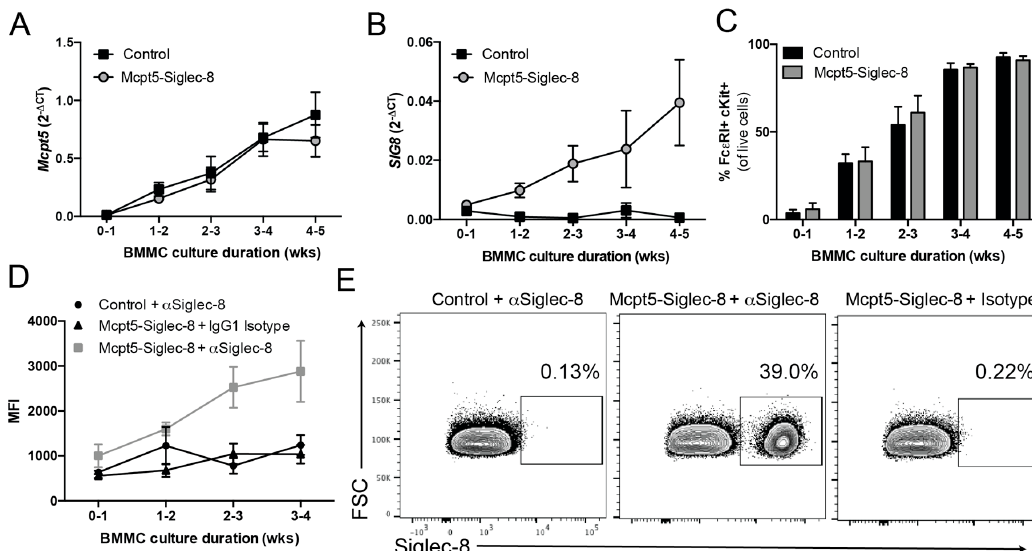
Figure 7. A subset of BMMCs from Mcpt5-Siglec-8 mice express high levels of surface Siglec-8. BMMCs were generated from Mcpt5-Siglec-8 ( n = 4) and control ( Mcpt5-Cre − / − SIG8 +/ − , n = 5) mice. ( A ) Mcpt5 and ( B ) Siglec-8 mRNA levels were quantified by qPCR weekly during the maturation of the mast cells; ( C ) purity of BMMCs was assessed weekly by flow cytometry showing % Fc ε RI + c-Kit + of live cells; ( D ) surface Siglec-8 protein expression was determined by flow cytometry; ( E ) representative flow cytometry plots of BMMCs (at four weeks) showing Fc ε RI + c-Kit + cells and gating for Siglec-8 + cells. Data are from three independent experiments, and the mean ± SEM of n = 4–5 are